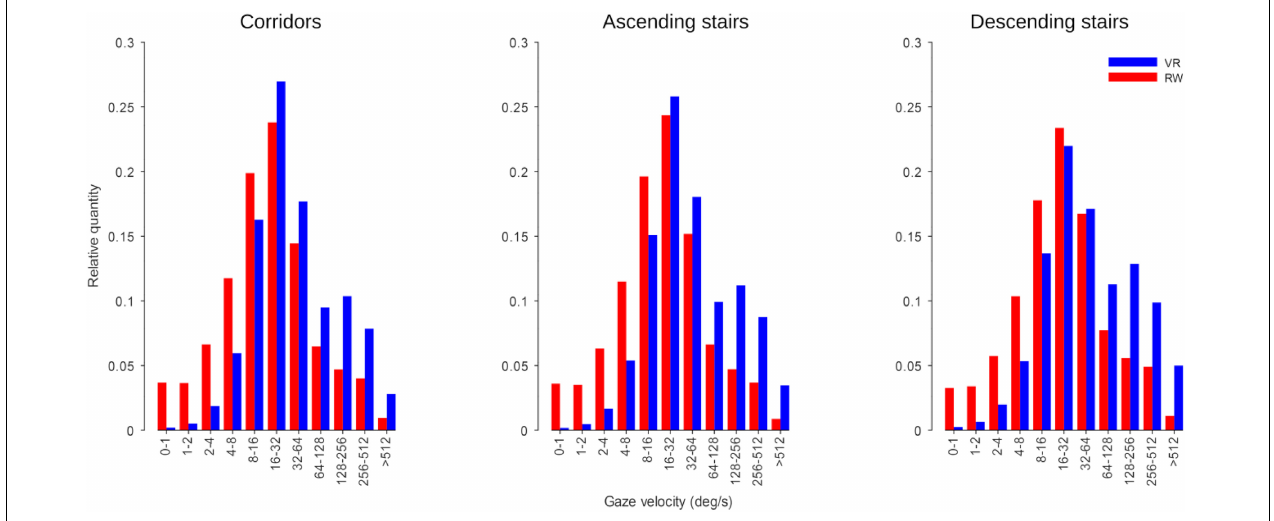
FIGURE 10 | Gaze velocity histograms. Velocity bins are log-spaced (in octaves) and labeled by the velocity contained each